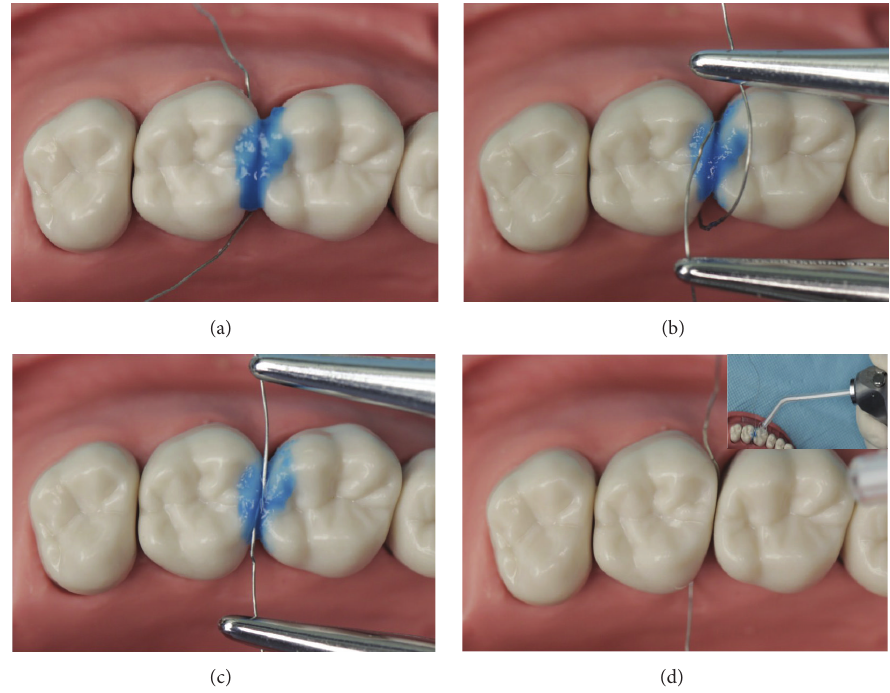
Figure 3: Acid-etching of the contact area under tension stress with the cerclage wire. (a) Applying 20% or 37.5% H 3 PO 4 gel around the contact area. ((b), (c)) The tension band was enforced with the cerclage wire by squeezing the acid agent into the contact area for 20 s. (d) Rinsing the acid agent thoroughly with